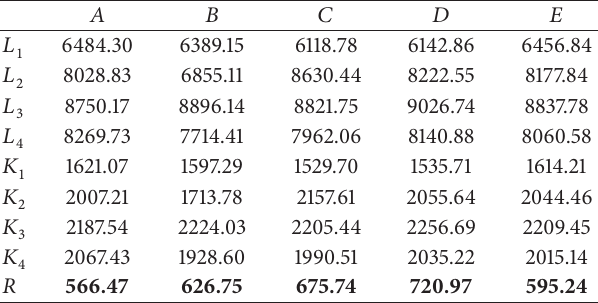
Table 12: Range analysis with apparent